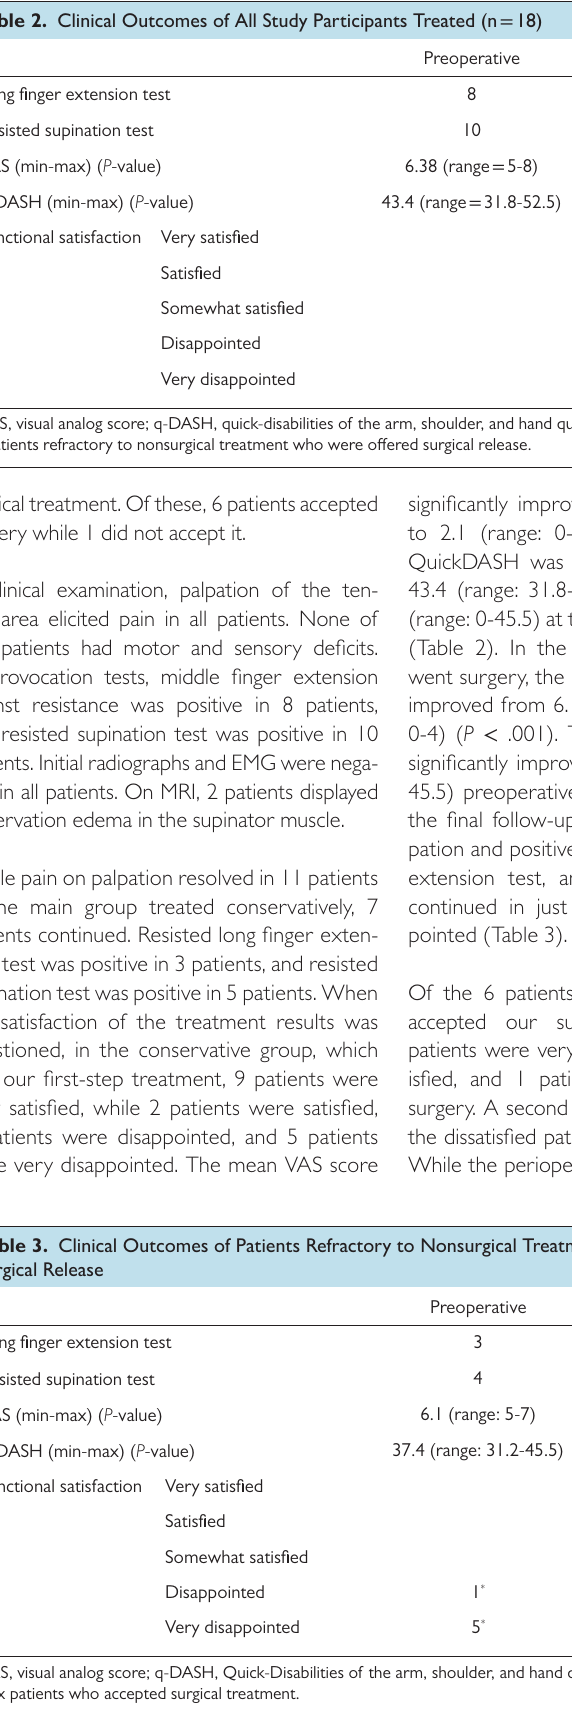
Table 2. Clinical Outcomes of All Study Participants Treated (n = 18) Preoperative Postoperative